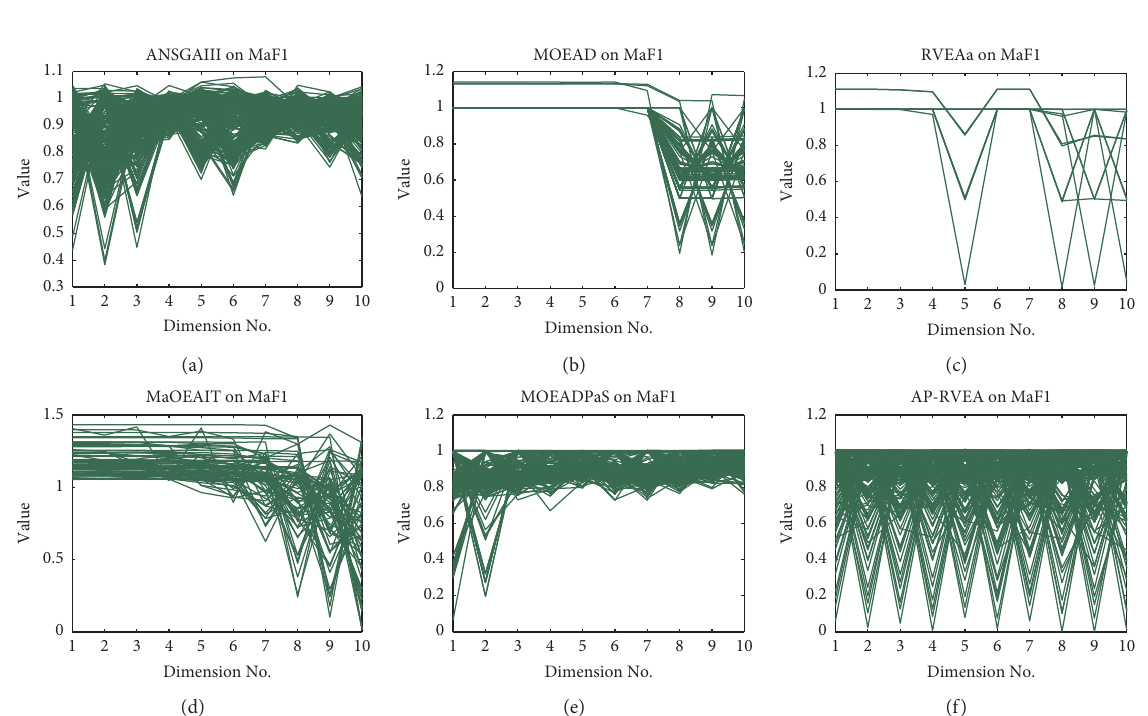
Figure 5: The best populations obtained by the six algorithms on 10-objective MaF1, shown by parallel